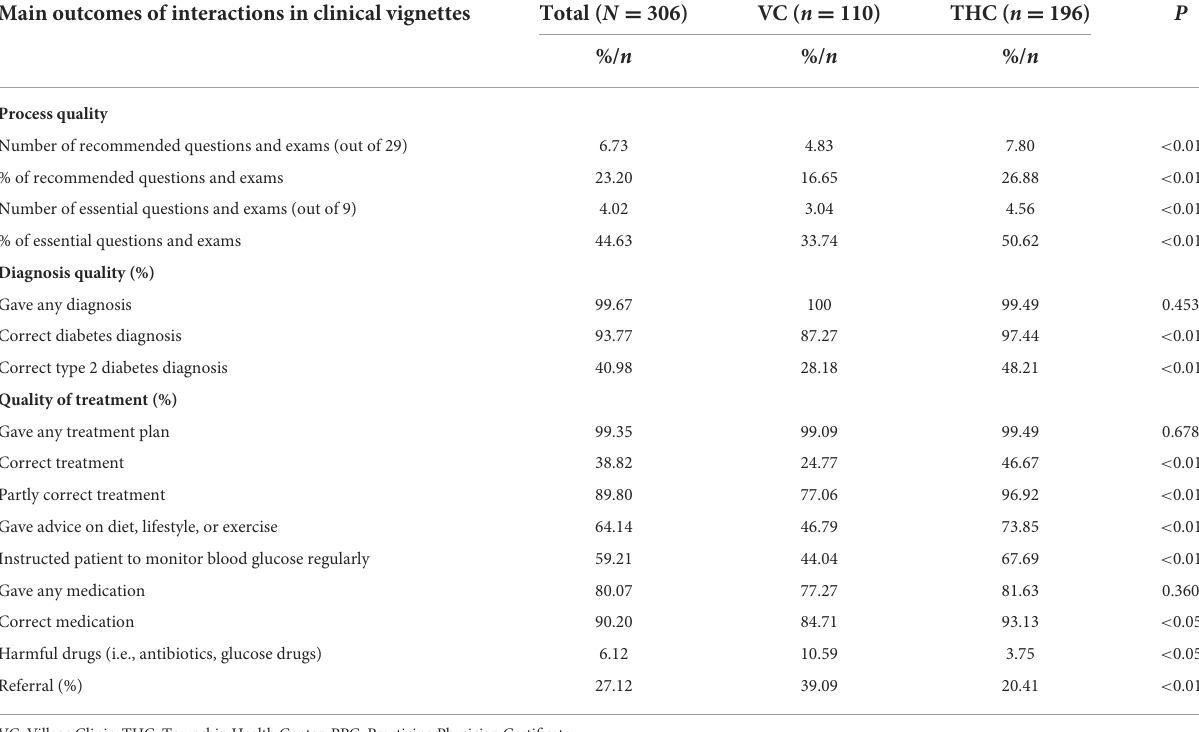
TABLE 2 Main outcomes of interactions in clinical vignettes for diabetes cases.